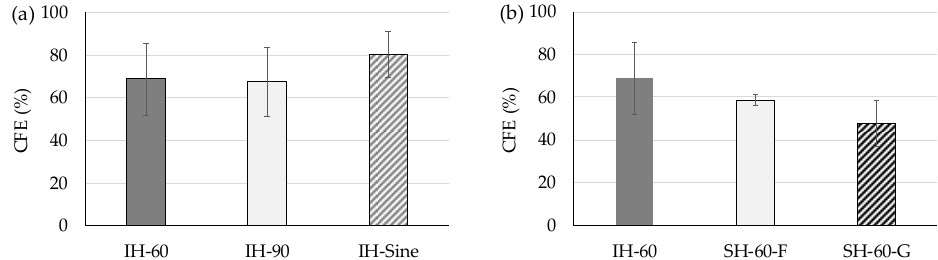
Figure 9. The average results of CFE for ( a ) webs having different frontal profiles and ( b ) webs having different stacking sequences.